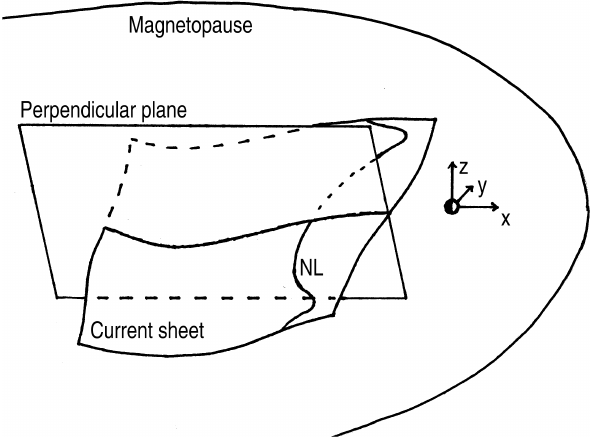
Fig. 3. A sketch illustrating the surfaces that we use to study re- connection in the magnetotail: the current sheet with a schematic neutral line (NL) drawn on it, and the perpendicular plane. See text for definitions.